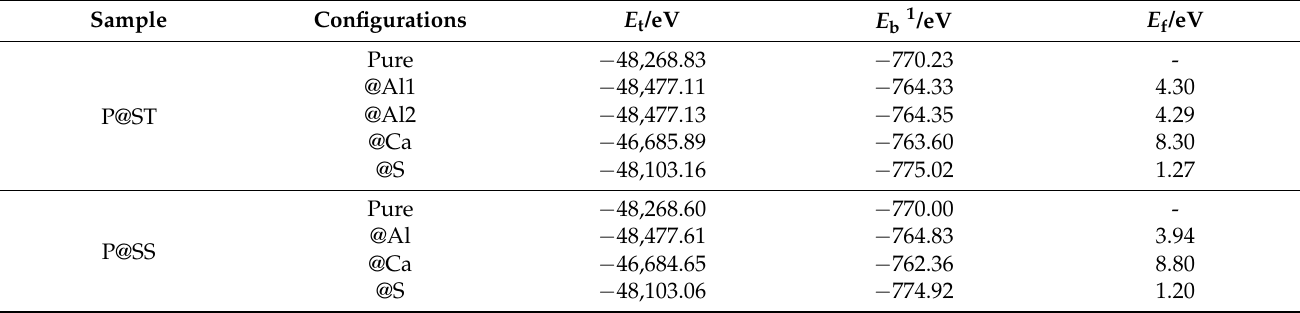
Table A3. Relaxed lattice parameters of the stable configurations including pure and P-doped clinker phases. Configurations